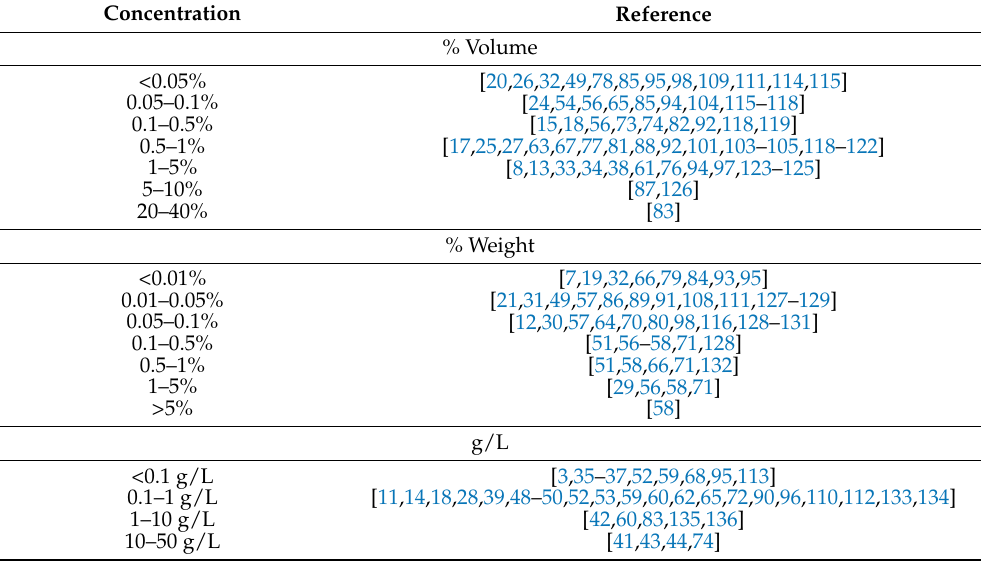
Table 2. Nanoparticle content in dielectric nanofluids in the revised literature.